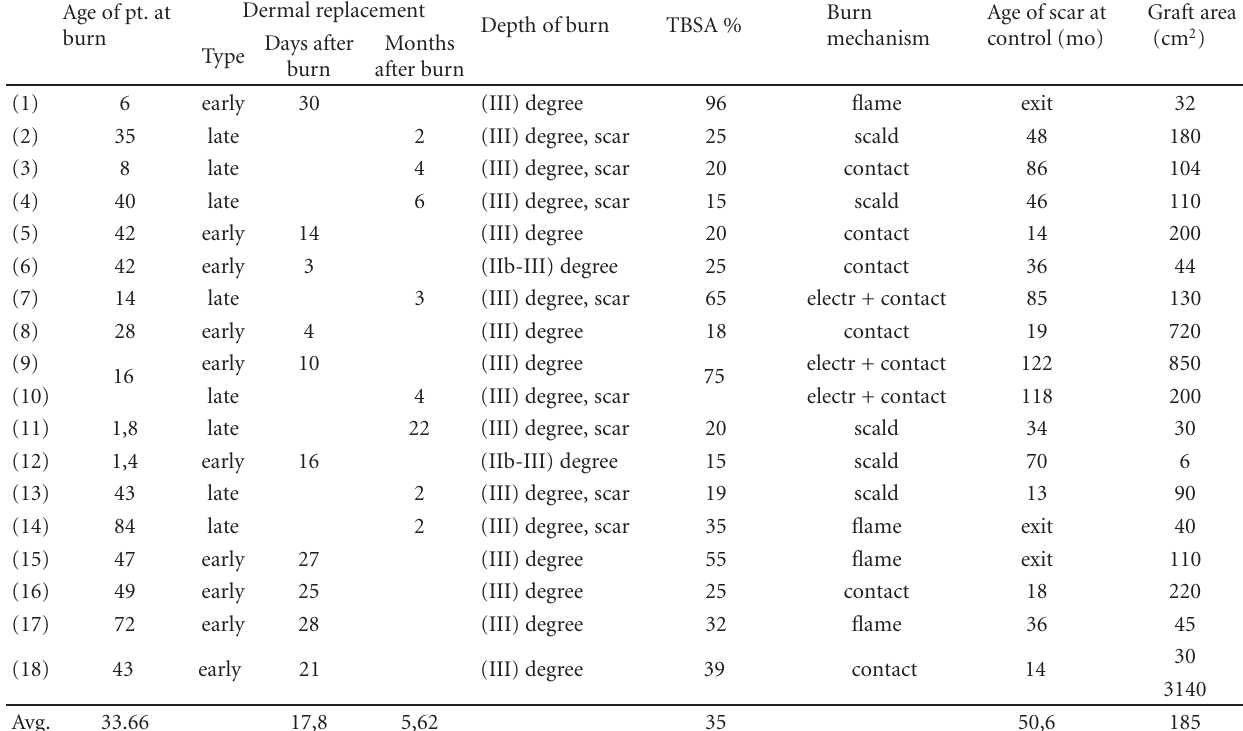
Table 2: List of patients grafted with a sandwich graft combining Alloderm regenerative tissue matrix and thin autologous split thickness skin graft. Age of pt. at